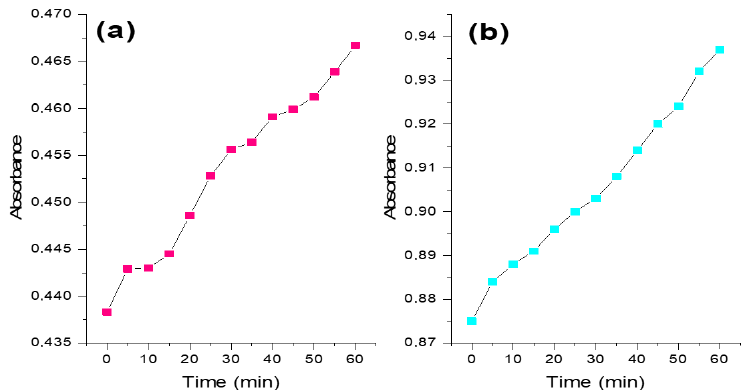
Figure 8. Phenol oxidation in the presence of ( a ) [(Cl) 2 Mn(RCOOET)] formed in situ and ( b ) pre- synthesized [(Cl) 2 Mn(RCOOET)] in MeOH.